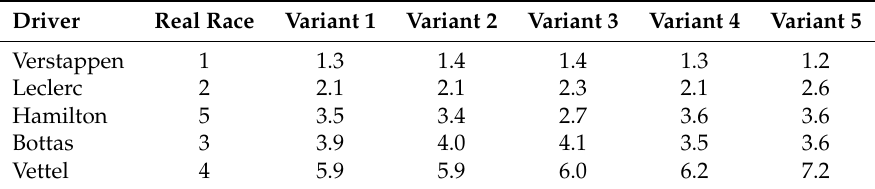
Table 19. Real and average result positions of the top five drivers after 10,000 simulation runs of the 2019 Austrian Grand Prix. Five different variants of race strategy determination are compared. Both probabilistic influences and randomly generated FCY phases were